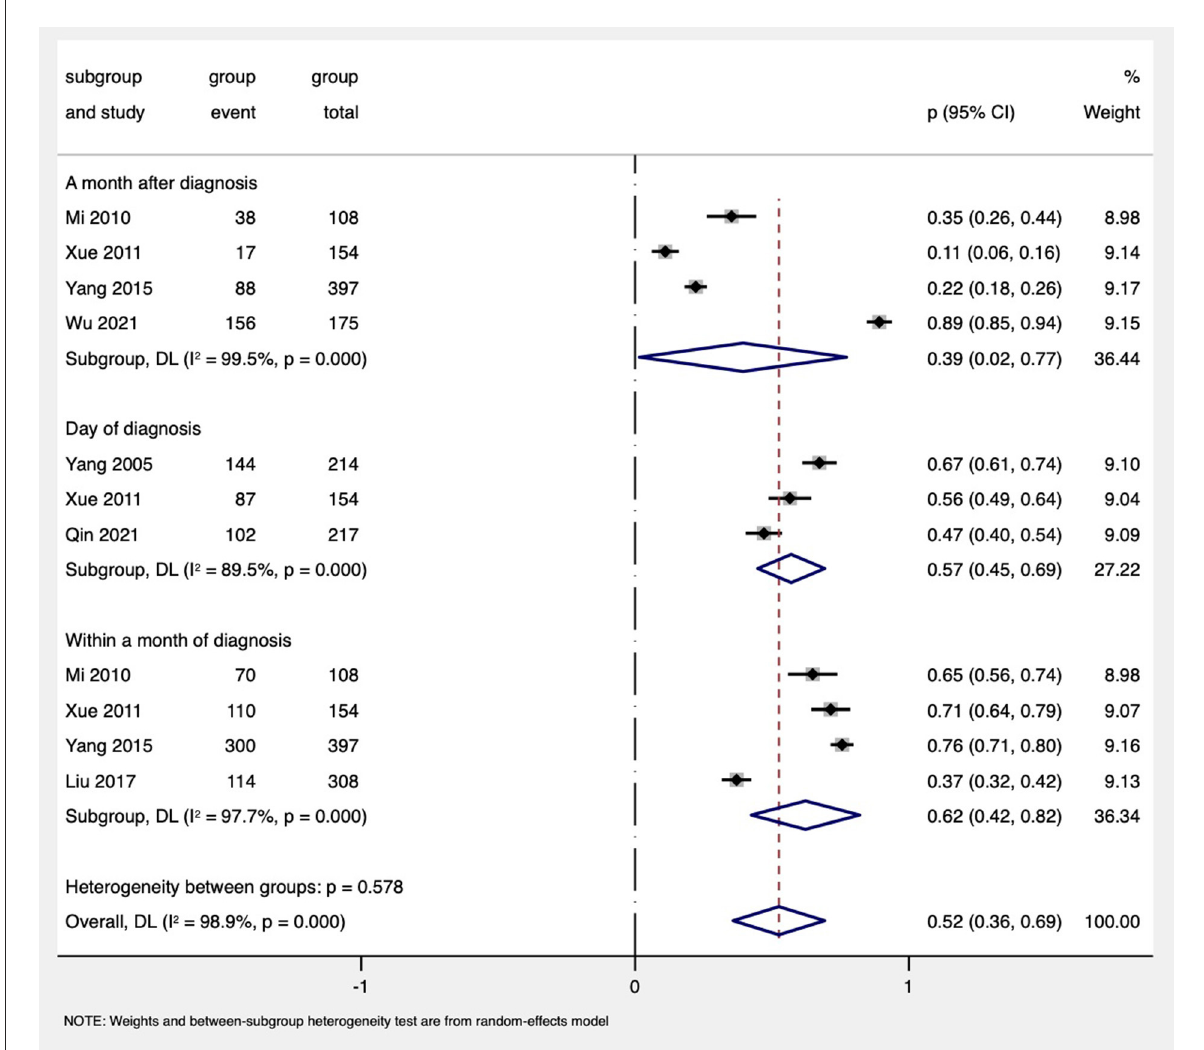
FIGURE4 Forest plot of subgroup analysis by disclosure at different diagnosis times among